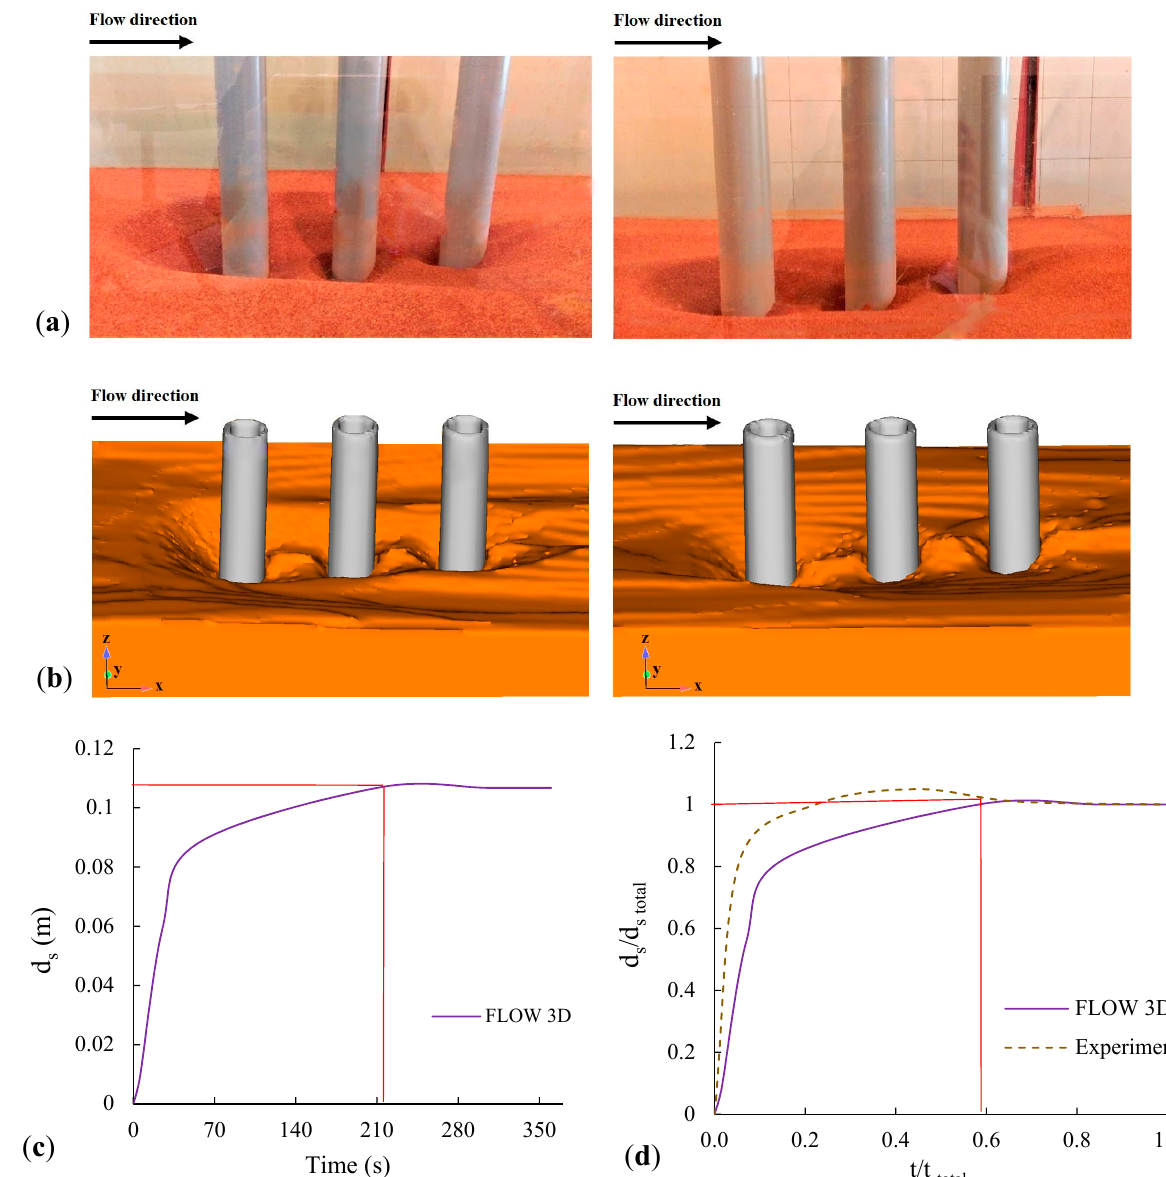
Figure 4. Comparison of scouring around the piers between the laboratory and numerical studies. ( a ) Laboratory scouring around the upstream and downstream pile groups. ( b ) Numerical scouring around the upstream and downstream pile groups. ( c ) Time changes of the local scouring depth in the laboratory model. ( d ) Comparison of the time changes of the local scouring depth between the laboratory model and the numerical simulation.